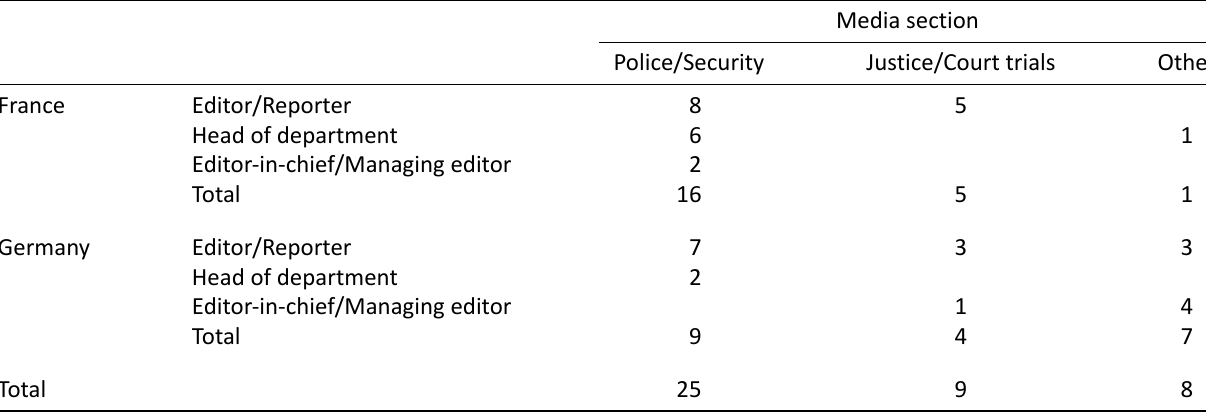
Table 1. French and German journalists interviewed (N = 42), according to their hierarchical rank and specialty.